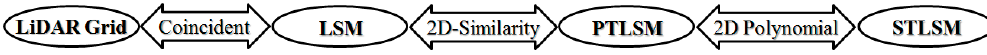
Figure 17. Flowchart of the individual shadow segment matching and coarse 3D-Model estimation.